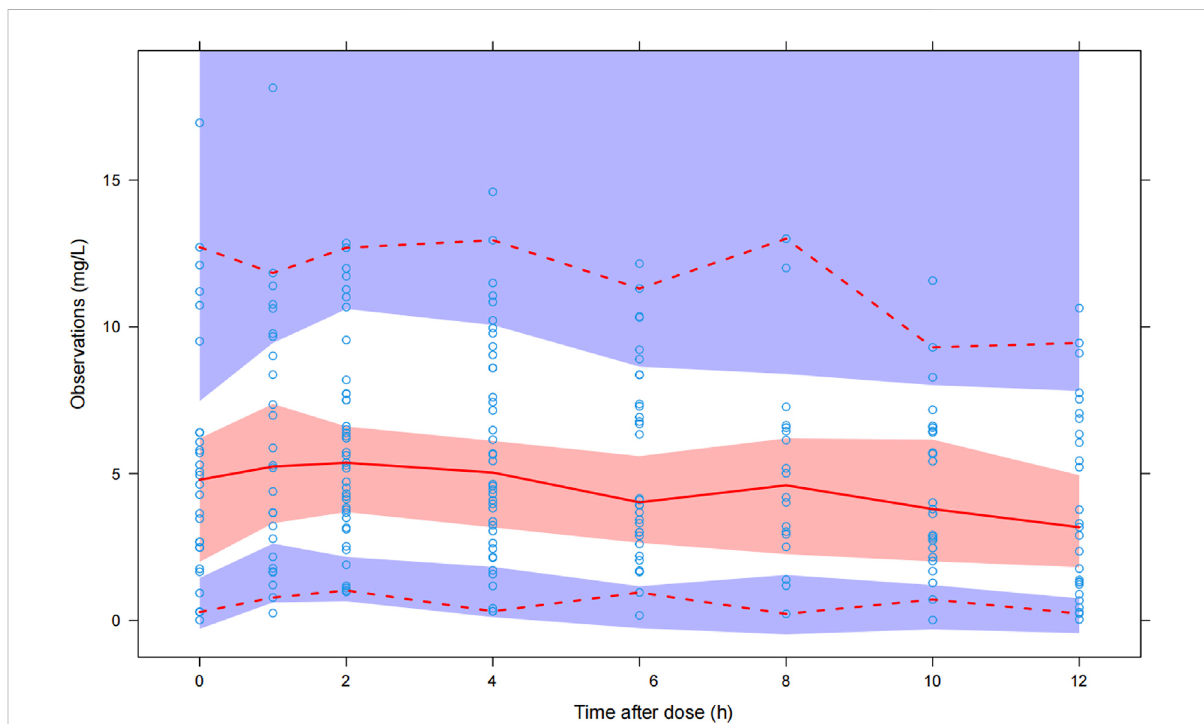
FIGURE 2 Visualpredictivecheckofthe fi nalmodel.ThebluehollowdotsrepresenttheoriginalobserveddateofVRCblooddrugconcentration,thesolid red line represents the median observed plasma concentration, and the red area represents the 95% con fi dence interval of the simulation-based median. The red dotted line represents the 5% and 95% percentiles of observed plasma concentration, the area formed between the two red dotted linesiscalledthe90% predictioninterval(PI),and thebluearea isthe95% con fi denceinterval for thecorresponding percentilepredictedbythe model.